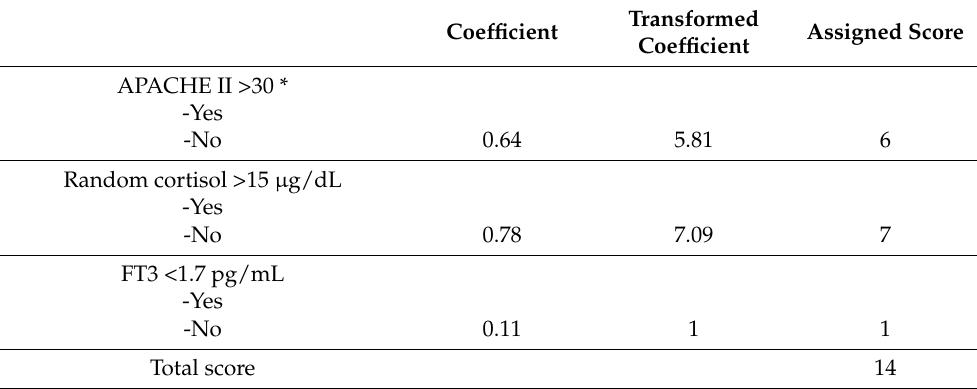
Table 5. Scoring system to predict ICU